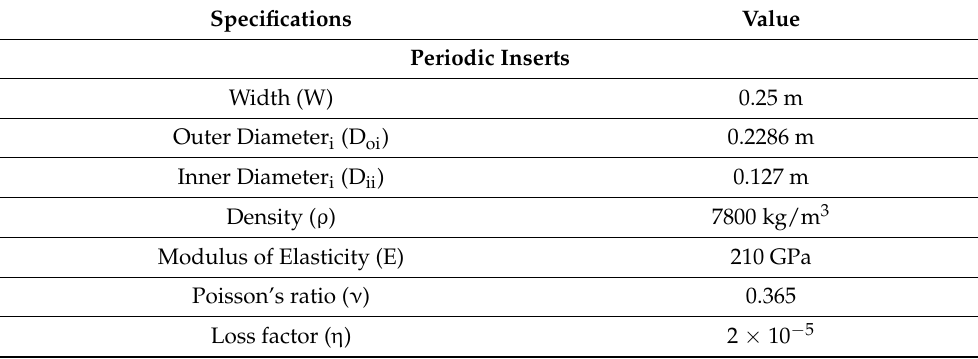
Table 2. Main physical and geometrical parameters of the considered periodic